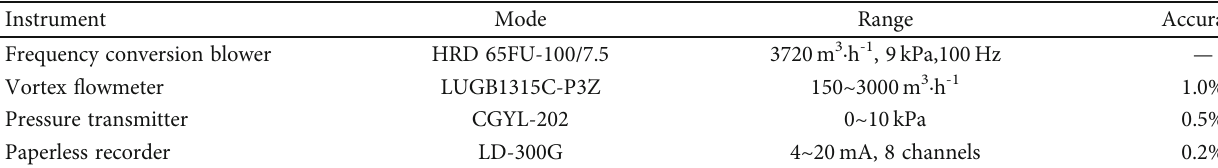
Table 1: Basic parameters of experimental instruments.